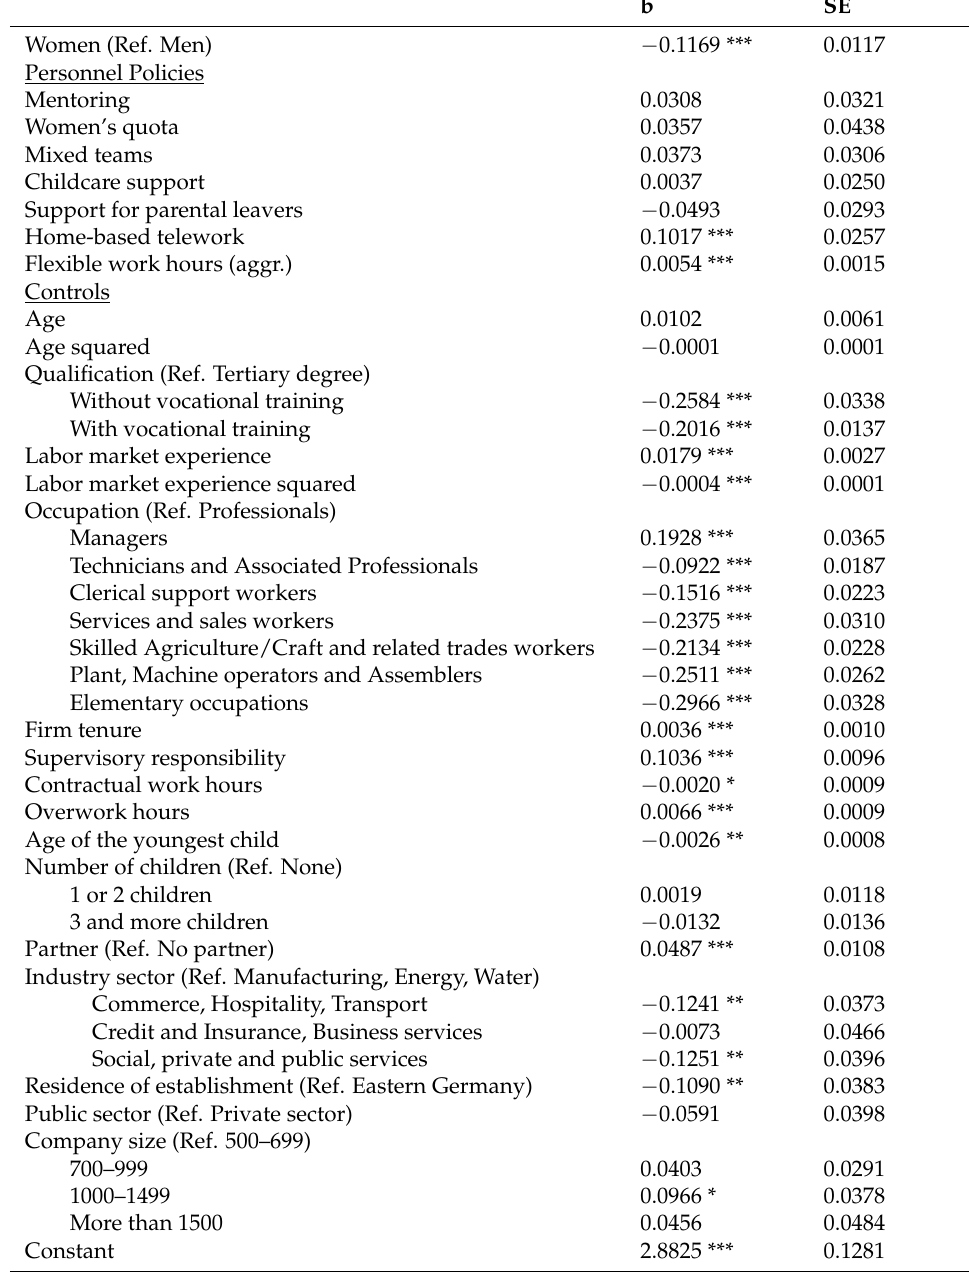
Table A2. The association of personnel policies and log hourly wages (Multi-level linear regression models with random